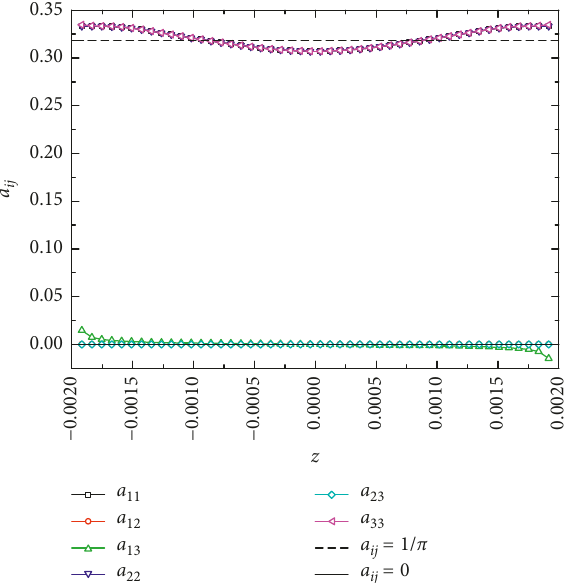
Figure 4: Components of a ij in z direction ( ϕ (cid:31) 1.4%, r (cid:31) 16).